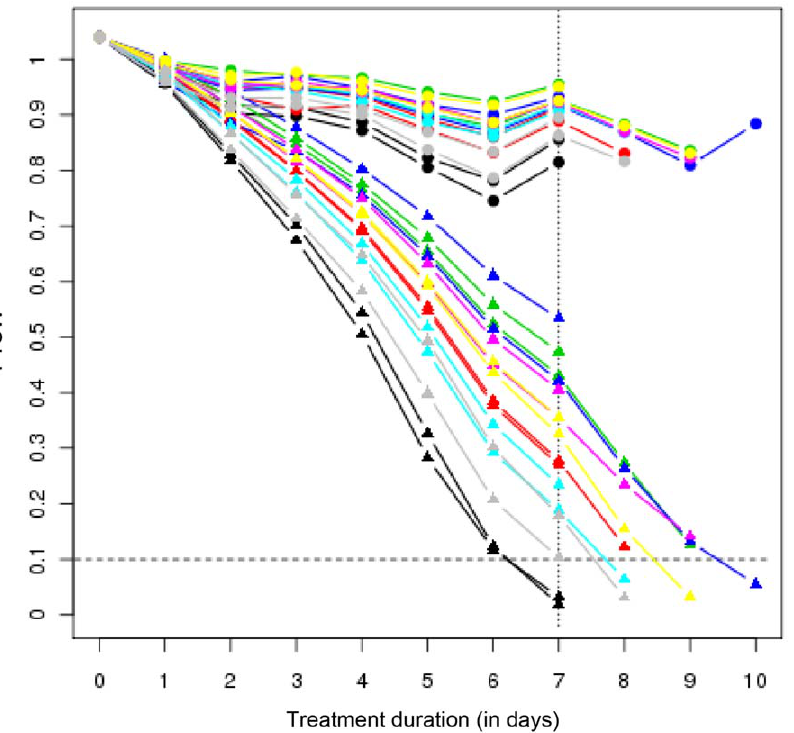
Figure 1. Evolution of Fraction of Transpirable Soil Water (FTSW) during water deprivation. Each line reflects the average values of three values for each genotype either under FDS or under FIS. Vertical dotted line indicates the date of the FDS tissue collection. Horizontal dotted line indicates the FTSW level at which FIS collection was carried out. Triangles correspond to treated plants whereas circles correspond to their untreated counterparts. Genotypes are color-coded as follows: Inedi (black), Tekny (gray), Melody (red), SF109 (turquoise), SF326 (yellow), SF193 (magenta), SF028 (green) and SF107 (blue).